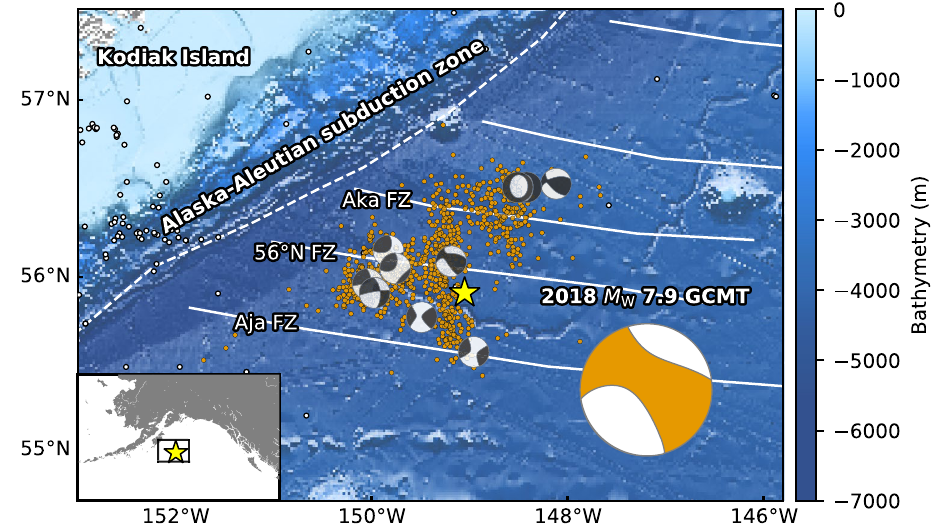
Figure 1. Overview of the source region of the 2018 Gulf of Alaska earthquake. The star is the mainshock epicenter, orange dots are aftershocks ( M ≥ 3) that occurred within one week of the mainshock, and white dots show background seismicity before the mainshock ( M ≥ 3.5, 1 January 2008 to 22 January 2018); all epicentral locations are from AEC 1 . The ‘beachball’ diagrams show the GCMT solutions for the mainshock (large, bottom right) and aftershocks with M ≥ 3.5. White dashed lines represent plate boundaries 18 , and white solid lines represent fracture zones 19,20 . The background bathymetry is derived from the GEBCO 2020 Grid 21 . The inset map shows the regional setting. This figure was made with matplotlib (v3.1.1) 48 , ObsPy (v1.1.0) 49 , and